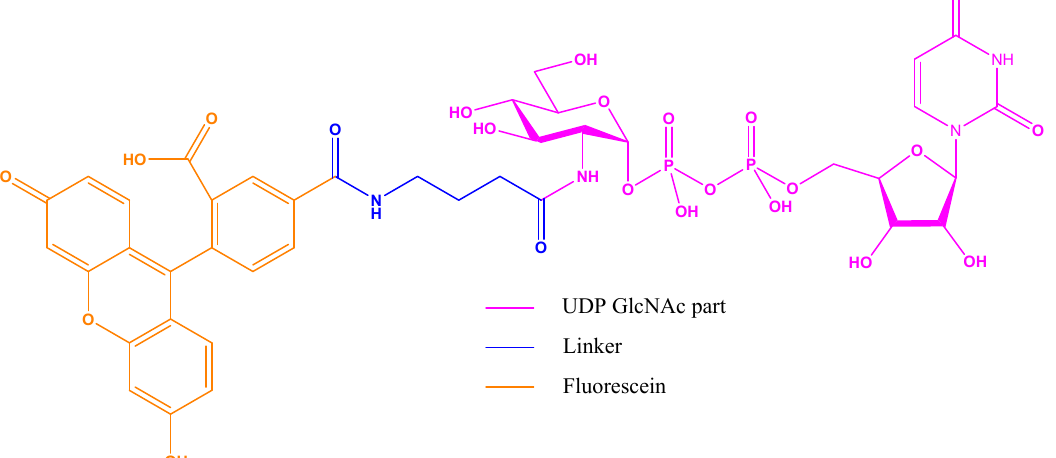
Figure 15. Fluorescent probe designed by Walker group in their fluorescence polarization (FP) assay: the binding part is UDP-GlcNAc with the extended acetyl group as linker to a fluorescein derivative.